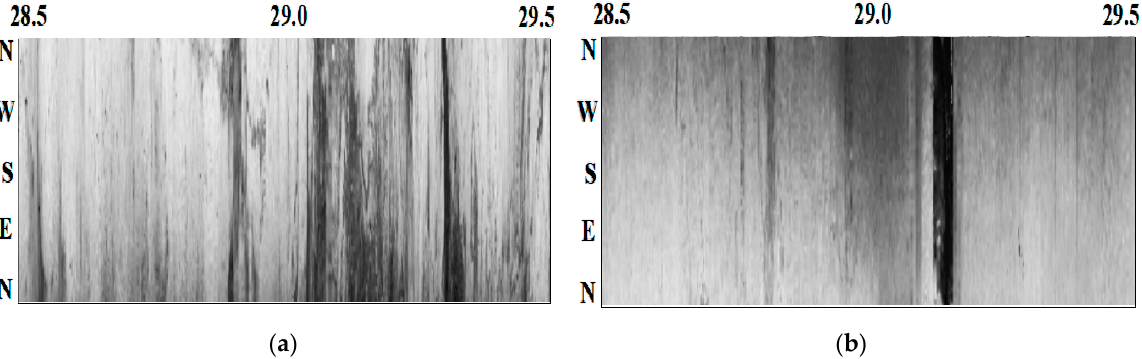
Figure 11. Acoustic scanning characteristics of rock walls. ( a ) Hole wall acoustic feature image, ( b ) hole wall contour feature image.